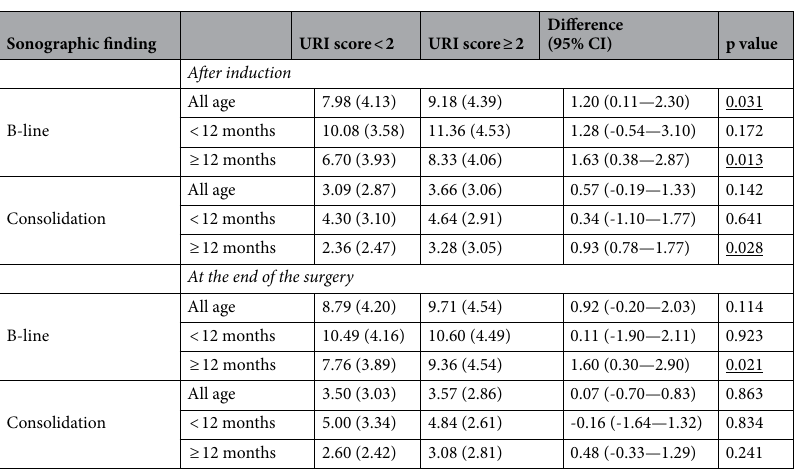
Table 4. Atelectasis scores (B-line, Consolidation) according to patient’s age after induction and at the end of the surgery periods; URI score < 2 (no or minimal URI) vs . ≥ 2 (mild or moderate URI). Values are presented as mean (SD) and mean difference (95% confidence interval). CI; confidence interval, URI; upper respiratory